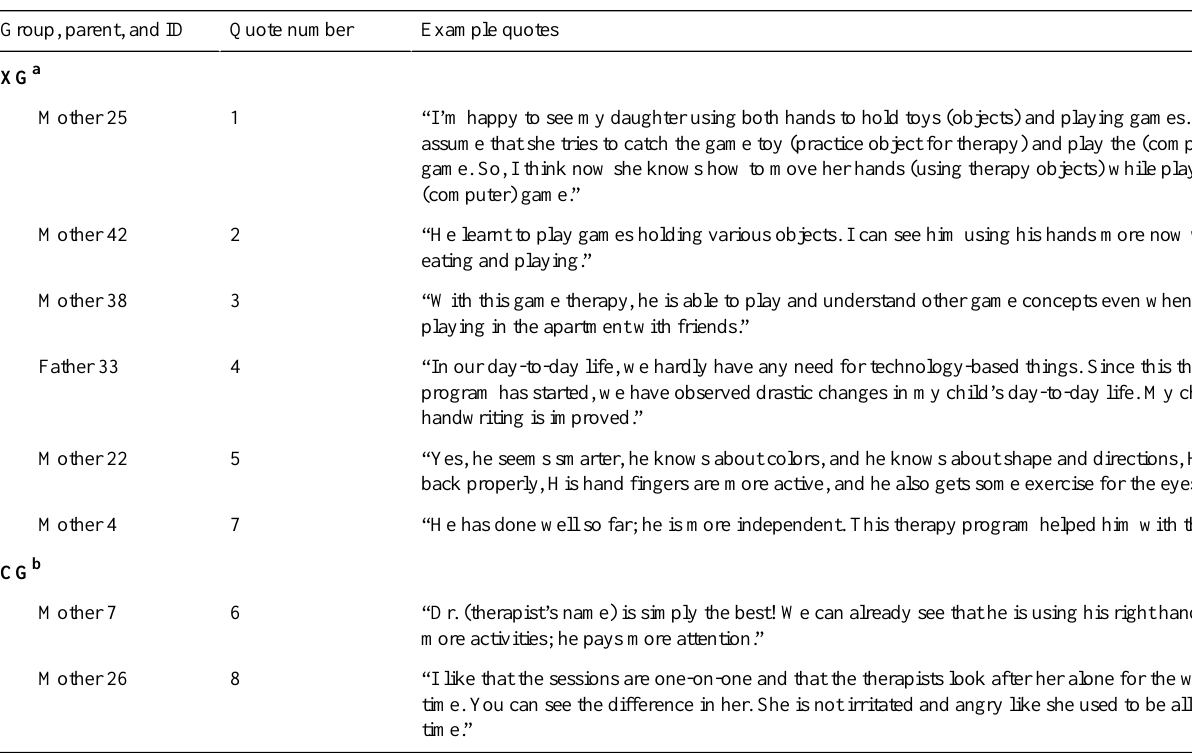
Table 5. Parents’responses about the positive effects of the interventions.